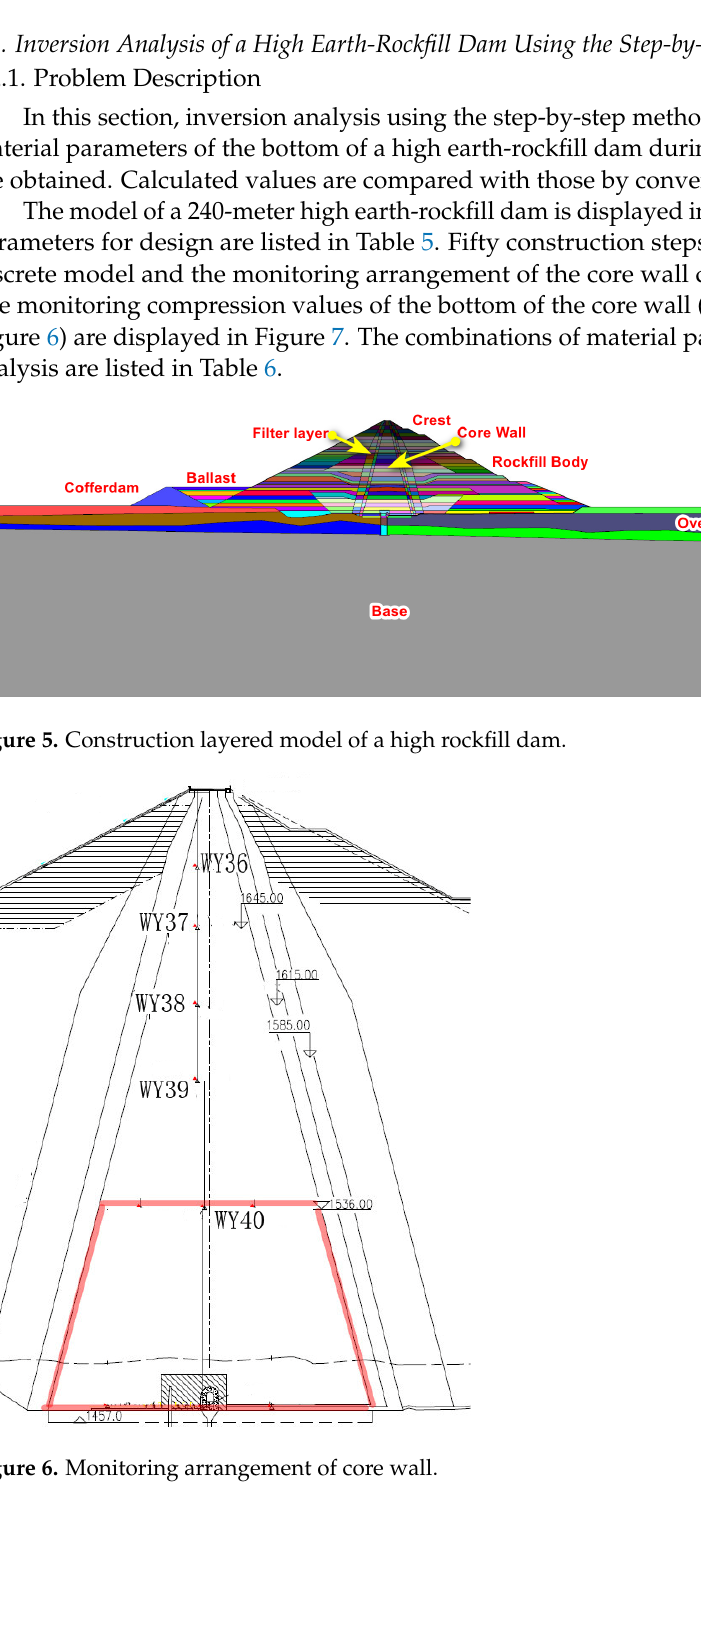
Figure 7. Monitoring compression values of the bottom of the core wall. 0200400 600800